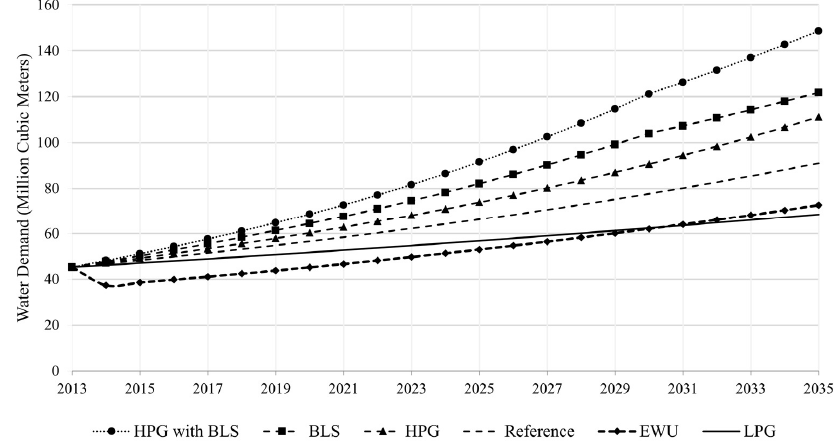
Figure 7. Annual Water demand projections in Million Cubic Metres (MCM) for different scenarios. Abbreviations: better living standards (BLS), high population growth (HPG), low population growth (LPG), efficient water use (EWU).